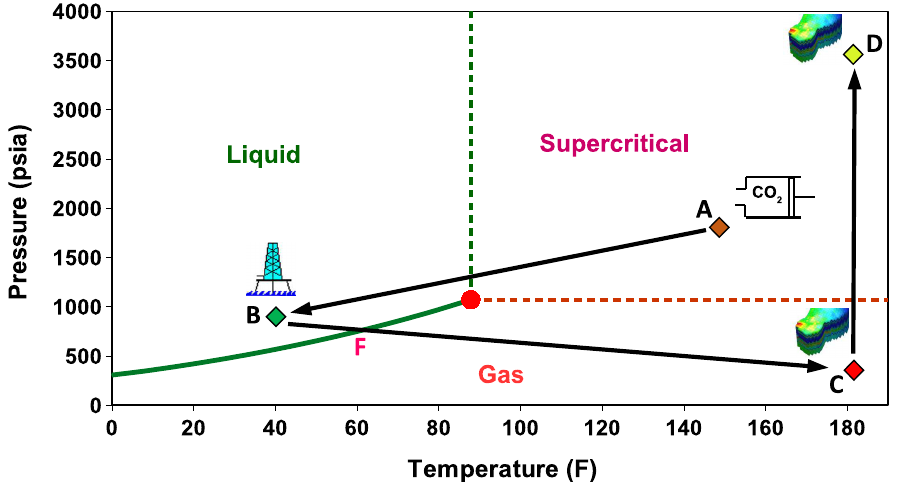
Figure 2. Pressure–temperature (PT) phase envelope showing the gas, liquid, and supercritical states of CO 2 as a function of pressure and temperature. Points A, B, C, and D, represent the pressure ( P ) and temperature ( T ) conditions of CO 2 during different stages of injection. A is the expected P and T after compression at the capture site, B is the expected P and T at the wellhead, C is the ( P , T ) conditions in the reservoir at the beginning of CO 2 injection, and D is the final ( P , T ) conditions after filling up the reservoir with CO 2 . S–L represents the transition point of CO 2 from the supercritical to the liquid state, and L–G is the transition point from the liquid to the gas